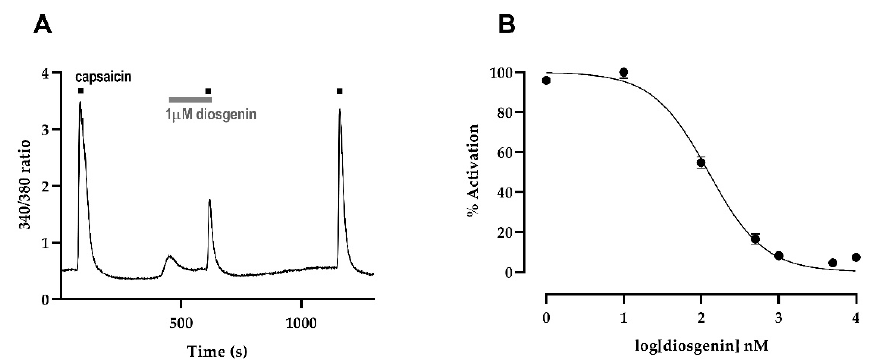
Figure 4. Diosgenin directly inhibits TRPV1 activation in CHO-K1 cells expressing human TRPV1. The capsaicin-induced calcium response is measured in cells pretreated with 1 µ M diosgenin ( A ). The half-maximal inhibitory concentration of diosgenin in human TRPV1-expressing CHO-K1 cells. The graph shows that diosgenin antagonizes capsaicin activation in a dose-dependent manner ( B ). Results are presented as mean ± standard error of mean. CHO: Chinese hamster ovary; TRPV1: transient receptor potential vanilloid 1.